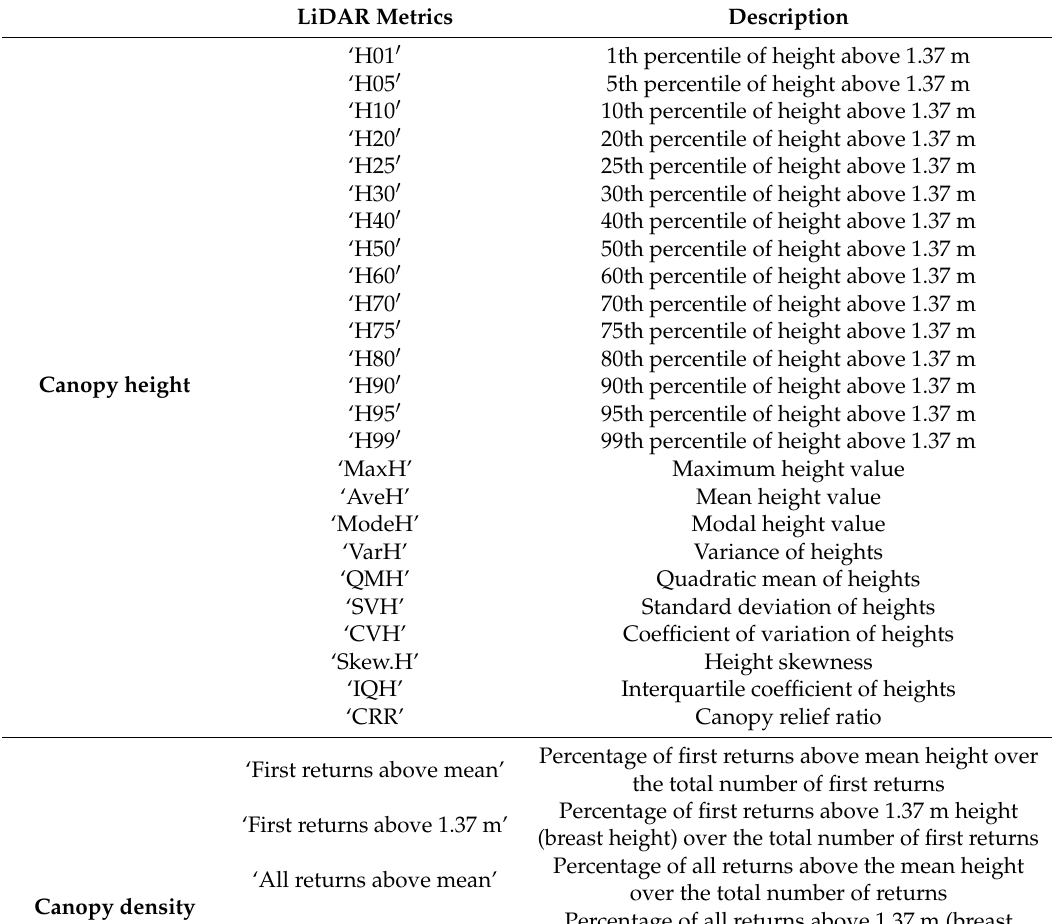
Table 1. Light Detection and Ranging (LiDAR) summary metrics gridded at 30 m resolution from LiDAR point clouds. Twenty-five metrics are related to vegetation canopy height, and eleven are related to canopy